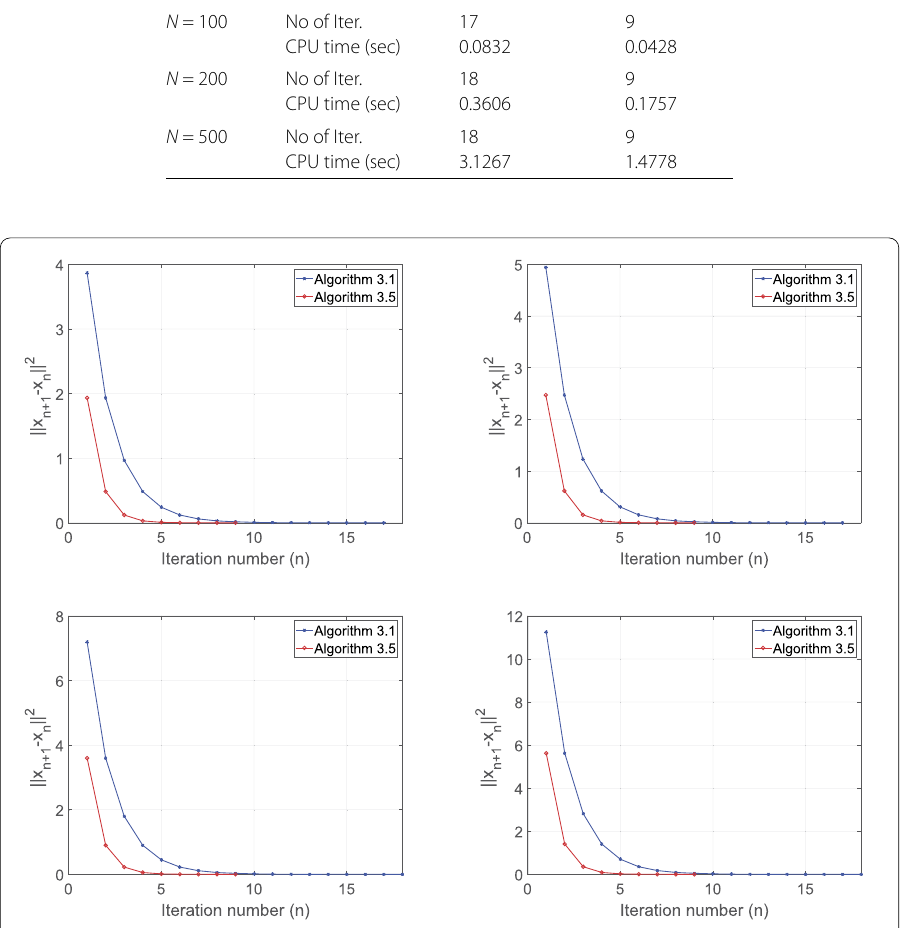
Algorithm 3.1 Algorithm 3.6